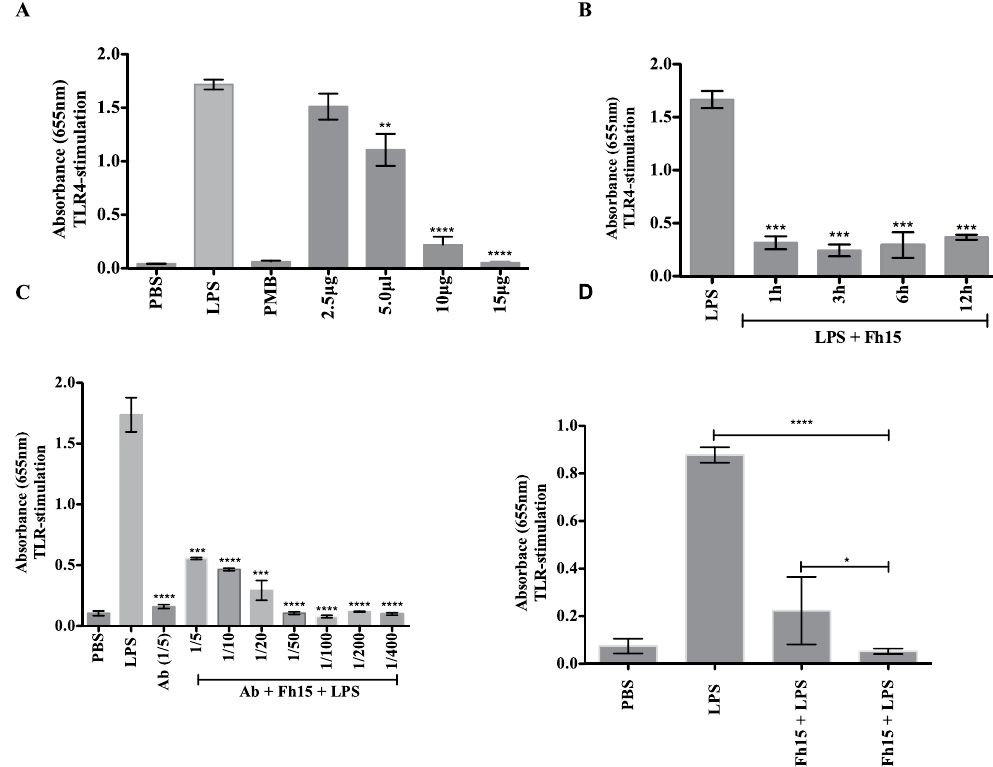
Figure 5. Effect of the heat treatment and the presence of anti-Fh12 antibodies on the capacity of Fh15 to suppress activation of different TLRs in THP1-Blue-CD14 cells. THP1 Blue-CD14 cells were seeded at 1 × 10 5 cells/well in 96-well flat-bottom plates. The levels of SEAP secreted to the culture media were estimated by reading at 655 nm, 18 h after TLR-ligand stimulation. ( A ) Cells were cultured with Fh15 (2.5 to 15 μ g/ml) before stimulation with LPS (1 μ g/ml). Fh15 significantly suppressed the LPS-induced TLR4-stimulation at concentrations of 5 μ g/ml ( ** p = 0.0012), 10 μ g/ml ( *** p = 0.001) and 15 μ g/ml ( **** p < 0.0001). ( B ) Cells were first stimulated with LPS (1 μ g/ml) and then exposed to Fh15 (10 μ g/ml) 1, 3, 6 and 12 h after LPS- stimulation. After 18 h of LPS stimulation, the QB-reagent is added to culture and readings at 655 nm were done 4 h later. Fh15 significantly suppressed the induced LPS-TLR4 stimulation at all time points tested after LPS- stimulation. *** p = 0.0001, ** p = 0.001. ( C ) The anti-Fh12 serum (endotoxin-free) at dilutions ranging among 1:5 to 1:400 was added in triplicate to culture followed of the addition of Fh15 (10 μ g/ml) before stimulation with LPS (1 μ g/ml). Fh15 significantly suppressed TLR-stimulation induced by LPS and the presence of high anti-Fh12 antibody concentration (1:5) make no difference ( *** p = 0.0001, **** p < 0.0001). ( D ) Cells cultured with untreated or heat denatured Fh15 ( Δ Fh15) for 10 min at 95 °C before stimulation with LPS (1 μ g/ml), demonstrate strong suppression against LPS-TLR4 induced stimulation ( **** p < 0.0001). Differences between both Fh15 and Δ Fh15 proteins were also observed ( * p =